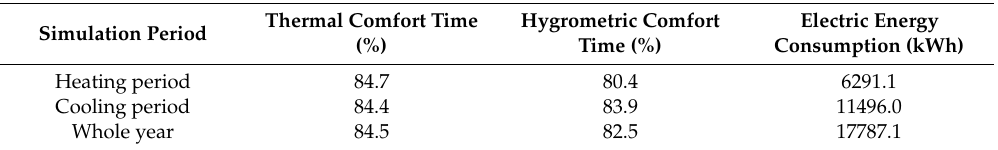
Figure 13. Daily profiles of return air temperature (T RA ) and return relative humidity (RH RA ) under normal operation: typical day of the heating period (1 February) ( a ), typical day of the cooling period day (1 July) ( b ). Table 11. Percentage of thermo-hygrometric comfort time and electric energy consumption during heating, cooling and whole year without faults.